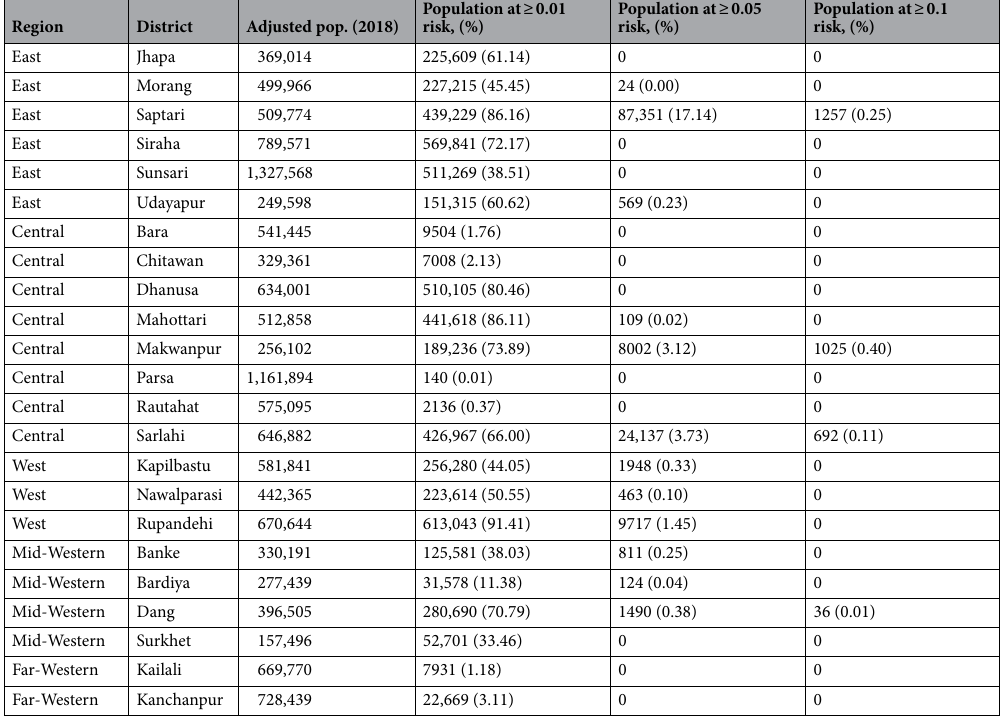
Table 3. Estimated adjusted population for 2018 in each district of the Terai (WorldPop), and population living in areas with snakebite risks larger or equal to 0.01, 0.05, or 0.1. All, the adjusted district population and the risk classes exclude the highly populated urban VDCs, removed by design, where no estimation was